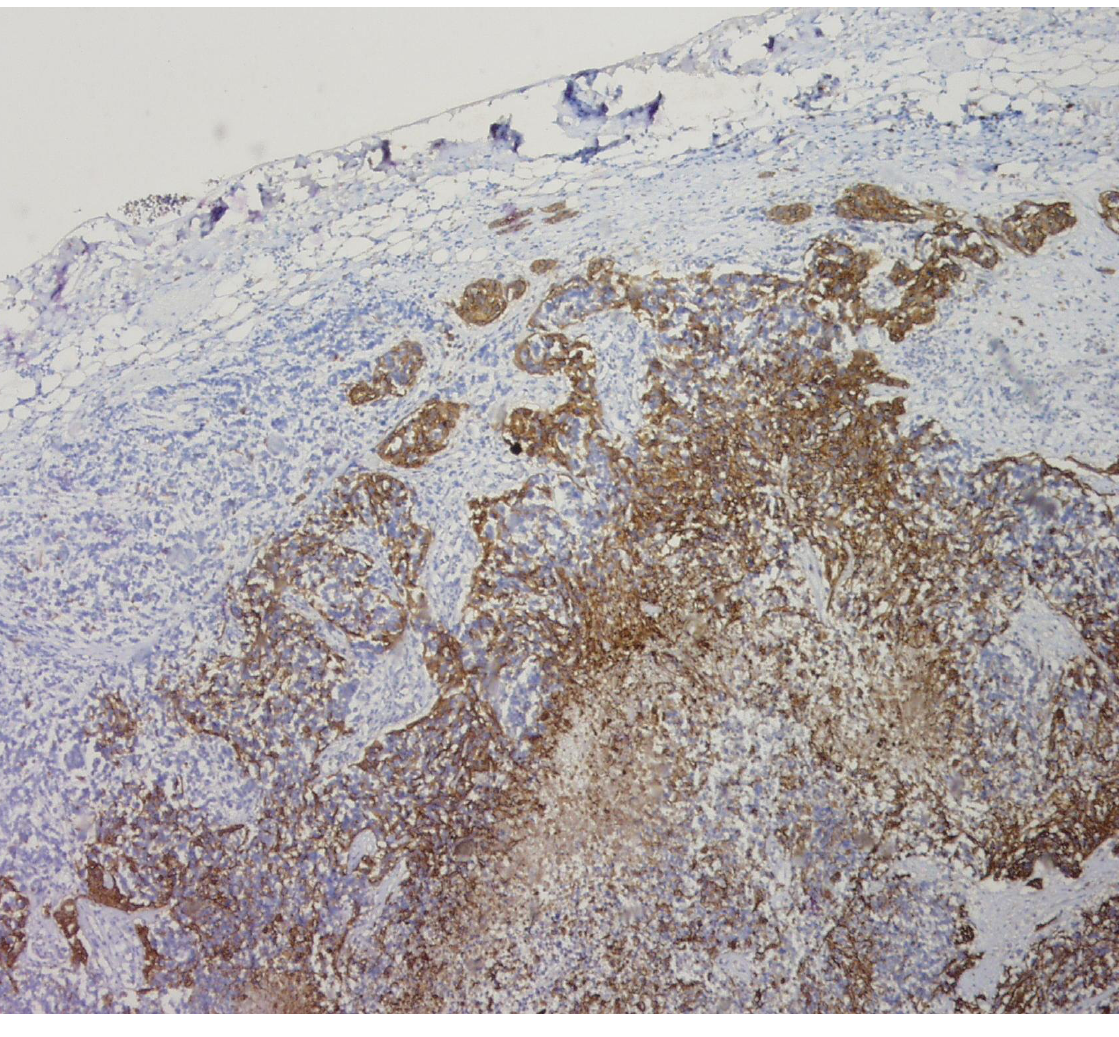
Figure 2. Photomicrograph demonstrating histological findings of the mediastinal lymph node metastasis. Positive immunostaining for glial fibrillary acid protein of lymph node (HES